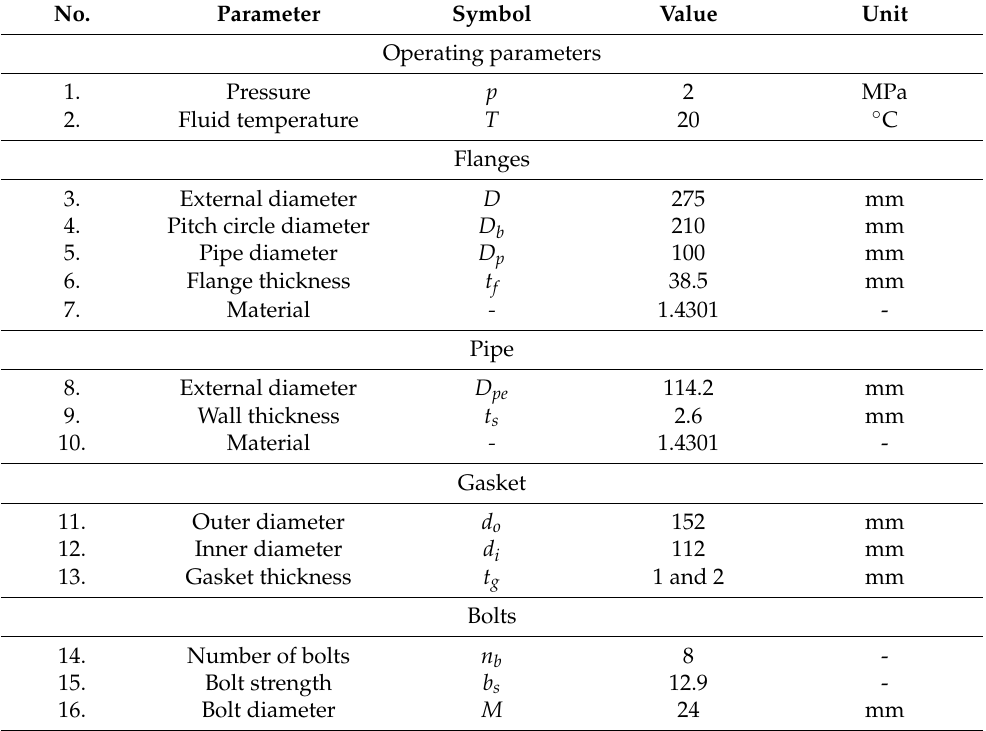
Figure 1. Model of the pipeline. Table 1. Basic geometrical dimensions of a flange joint.